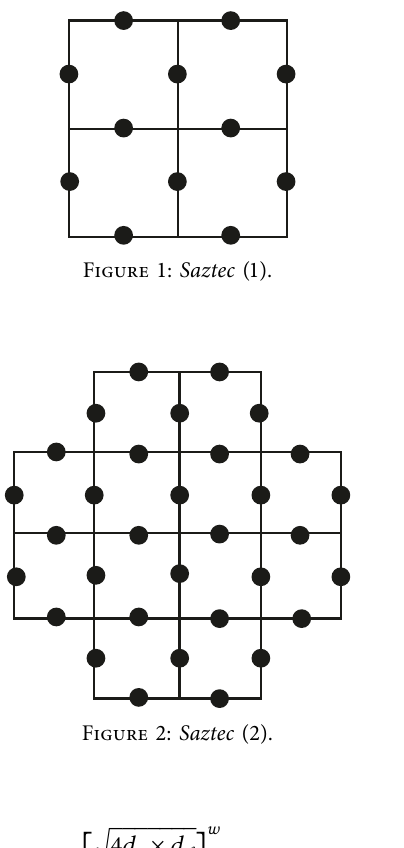
Figure 2: Saztec (2).